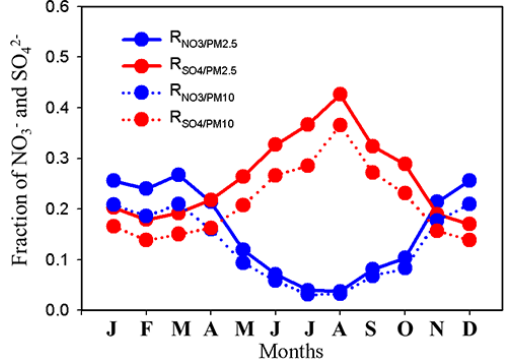
and 3 / PM 2 . 5 ) con- and R SO 4 / PM 10 4 / PM 2 . 5